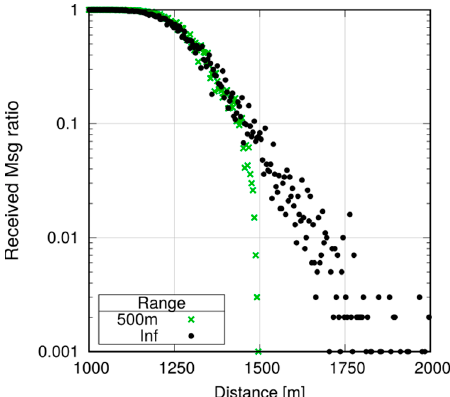
Figure 27. Reception probability in the multihop case, h = 250 m.